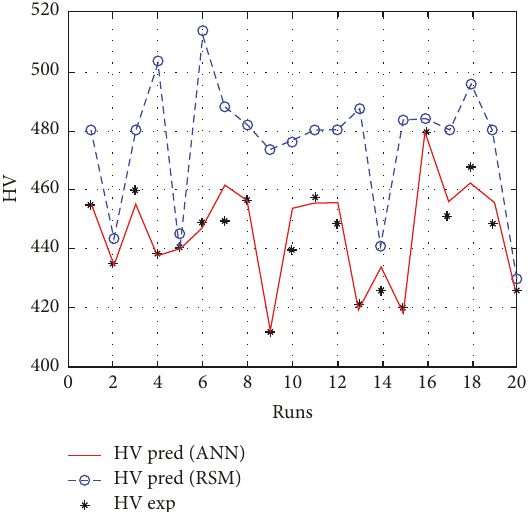
Figure 8: Experimental, RSM, and ANN predicted results for HV